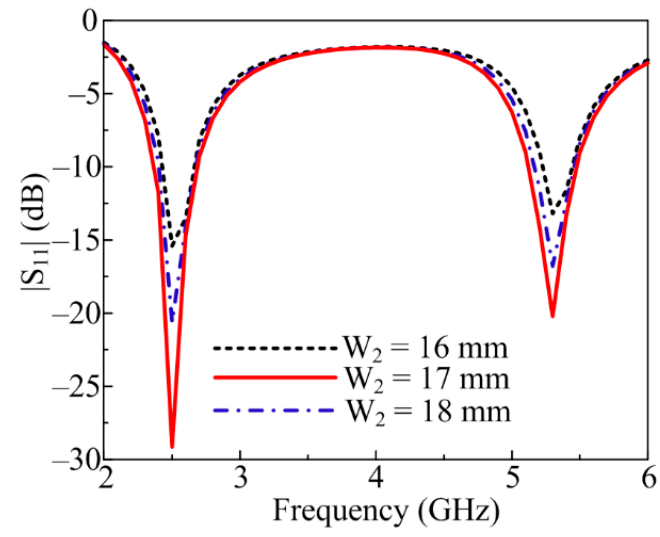
Figure 4. Parametric analysis of proposed antenna by varying upper stub (W 2 ).